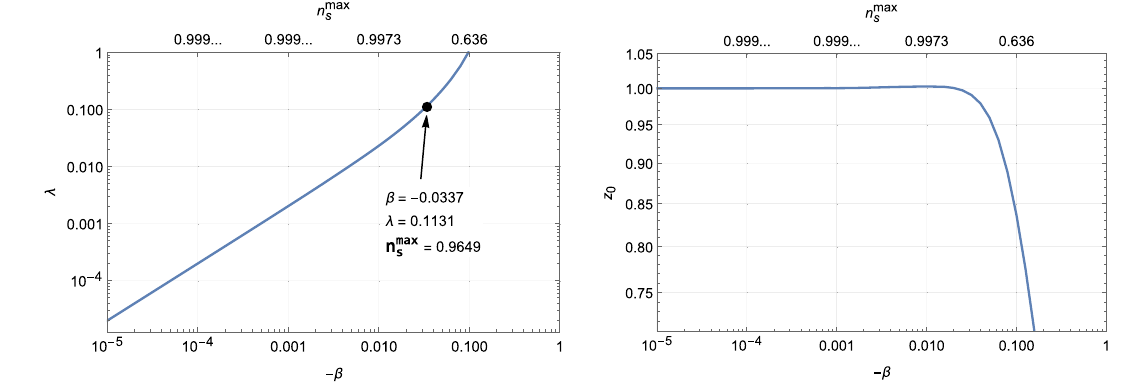
Fig. 7 Solution to the vacuum equations V z = V = 0 ( α = 3 case) with negative β : λ( − β) (left) and z 0 ( − β) (right)